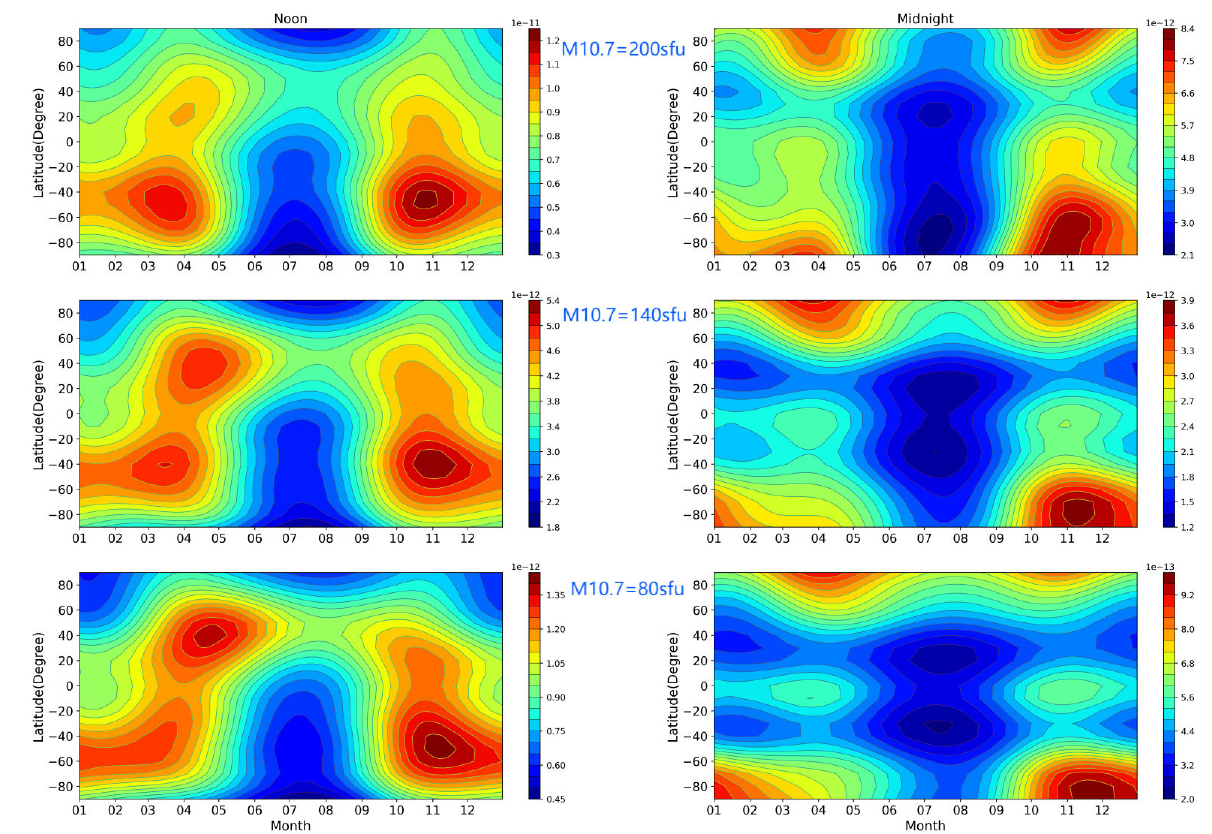
Figure 8. Same as Figure 7, but for the thermospheric density at 400